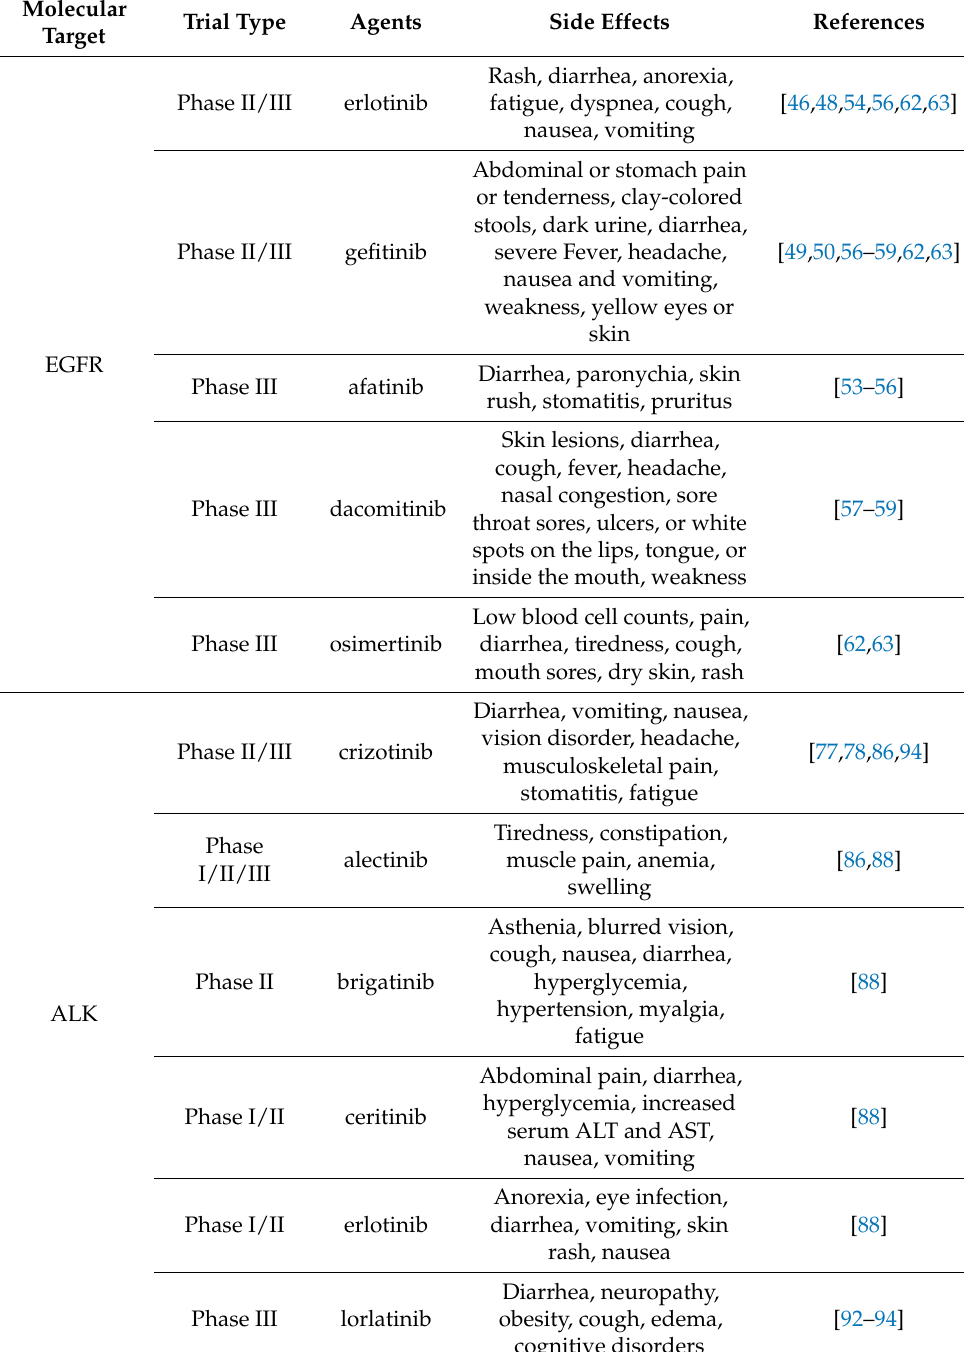
Table 1. Currently approved targeted therapies and related side